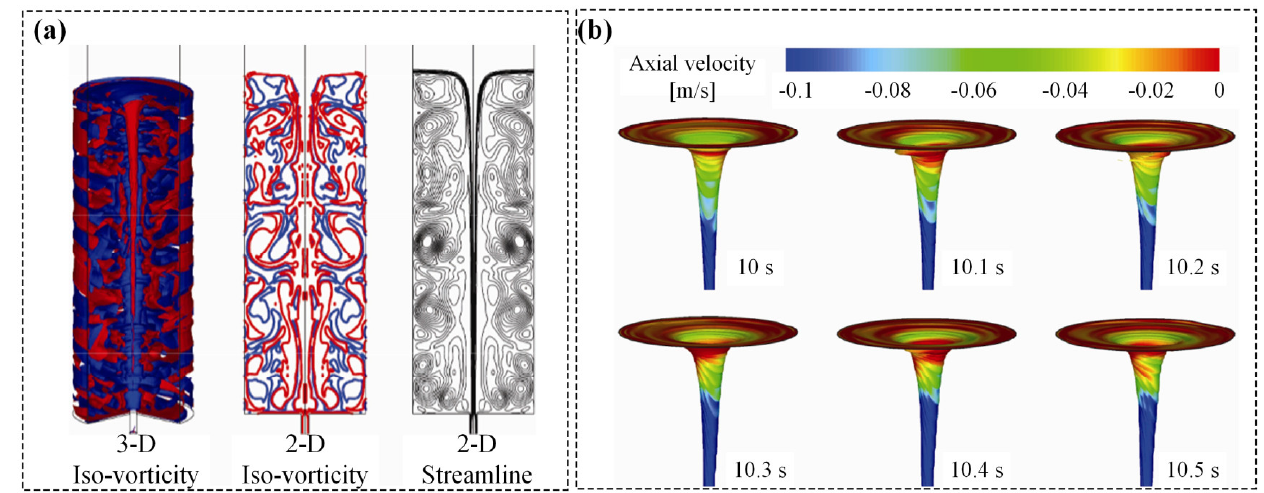
Figure 10. Spiral Taylor vortex core and spiral surface waves. ( a ) Vorticity streamline distribution. (Reprinted with permission from Ref. [84]. 2018, Springer Nature.) ( b ) Axial velocity of gas core surface. (Reprinted/adapted with permission from Ref. [85]. 2019, Springer Nature.)